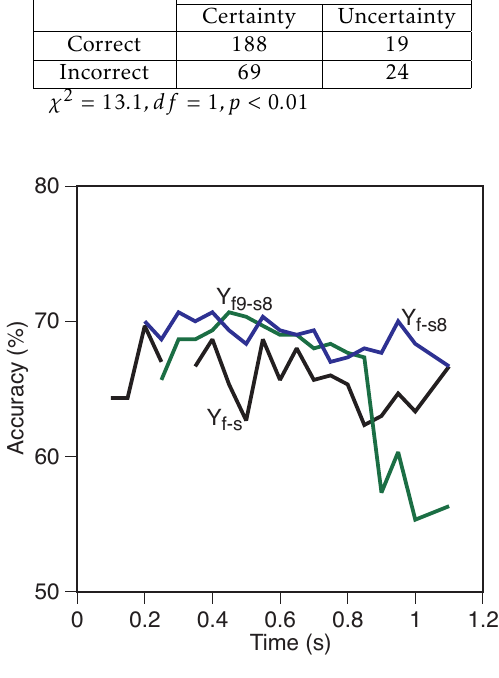
Figure 5. Prediction accuracy across the viewing time